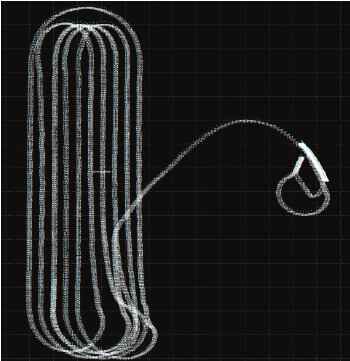
Figure 13. ATISS test-flight path RMS L1/L2 GNSS observations Table 3. Direct georeferencing accuracy of nadir